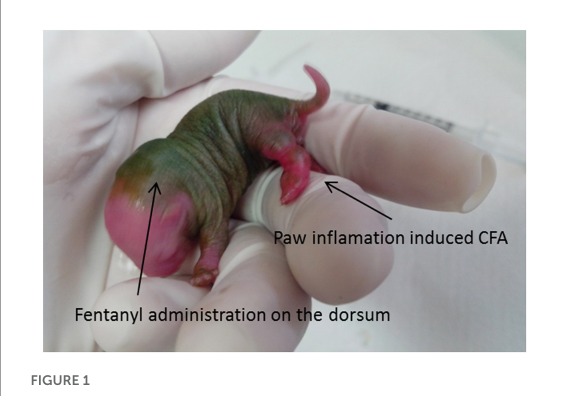
FIGURE1 CFA injection. Note the robust inflammation in the left paw. The fentanyl administration on the dorsum was subcutaneous. CFA, inflammatory agent complete Freund’s